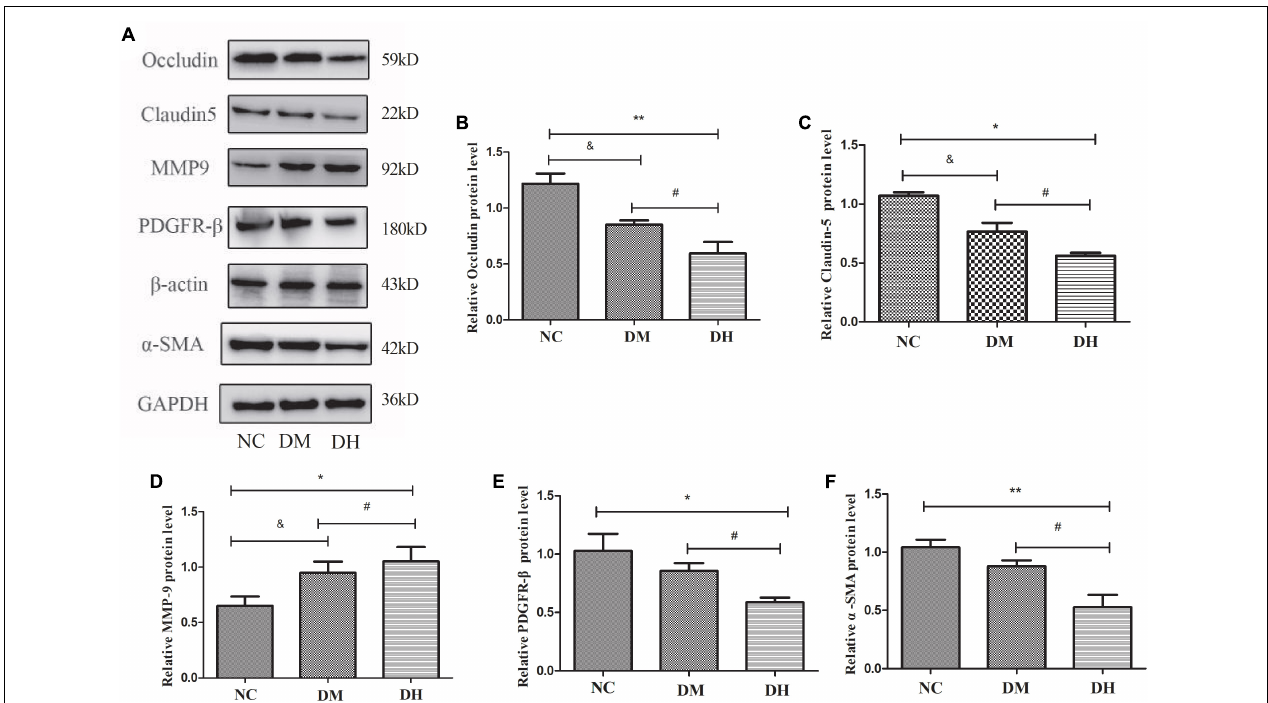
FIGURE 7 | Severe hypoglycemia caused reduced expression of BBB TJ binding proteins and pericyte-specific proteins. (A) Representative immunoblot images of relative protein expression. Western blot analysis was performed for the protein levels of occludin (B) , claudin-5 (C) , MMP9 (D) , PDGFR- β (E), and α -SMA (F) . N = 3 per group. Data are the means ± SEM. & P < 0.05 NC vs. DM. * P < 0.05 NC vs. DH, ** P < 0.01 NC vs. DH, # P < 0.05 DM vs. DH.